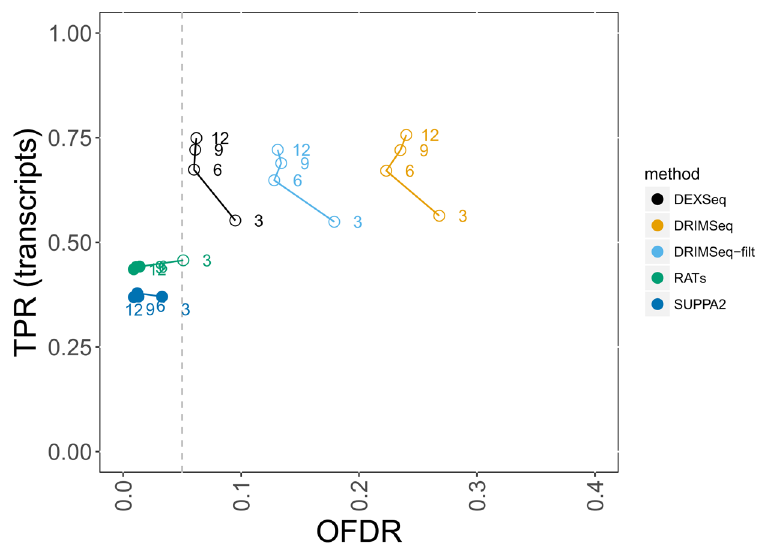
Figure 7. Number of true positives and observed overall false discovery rate (OFDR) using stageR for a 5% target. Each method is drawn as a line, and the numbers to the right of the points indicate the per-group sample size. Adjusted p-values for a nominal 5% OFDR (dashed vertical line) were generated for DEXSeq, DRIMSeq (with and without post- hoc filtering), RATs, and SUPPA2 from gene- and transcript-level p-values using the stageR framework for stage-wise